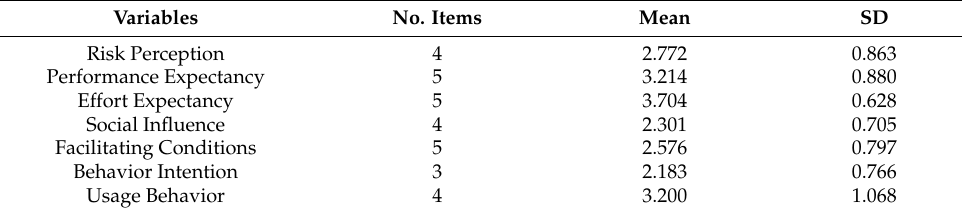
Table 2. Descriptive